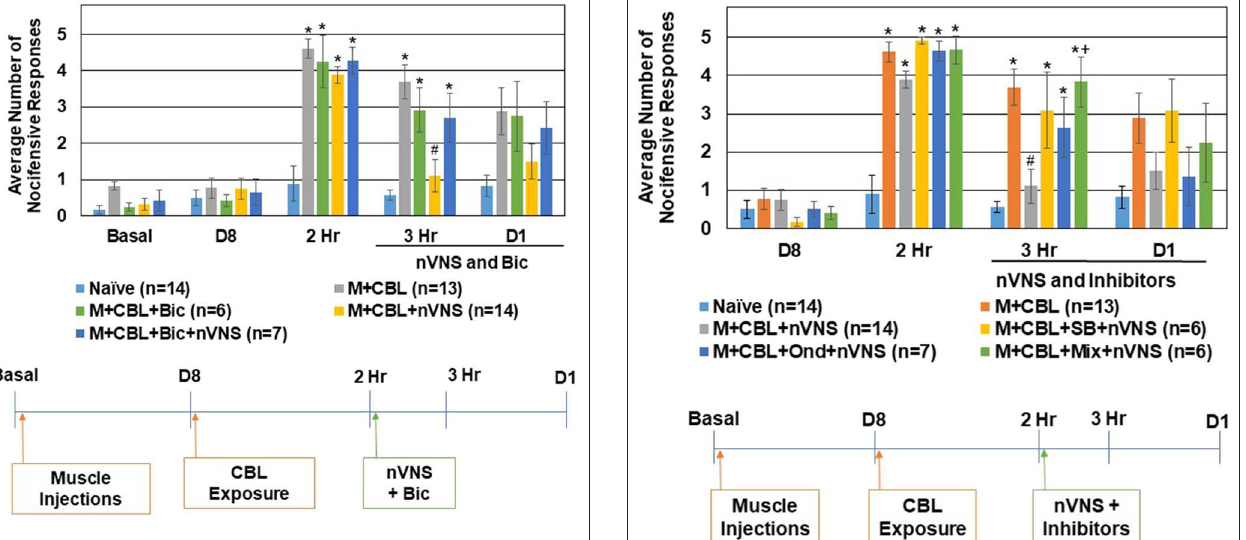
FIGURE 3 | Inhibitory effect of nVNS on trigeminal nociception involves GABA A . The average nocifensive head withdrawal response ± SEM of 5 applications to each side to mechanical stimuli are reported. Some animals were left untreated (Naïve), some were injected with complete Freund’s adjuvant 8 days prior to exposure to a pungent extract from California Bay Laurel leaves (M + CBL) and nociceptive responses determined at 2h, 3h, and 1 day post CBL exposure. Some of the M + CBL animals were treated with Bicuculline and/or nVNS 2h after CBL exposure and nociception measured 1h and 1 day post treatment. * P < 0.05 when compared to Naïve while # P < 0.05 compared to M + CBL.